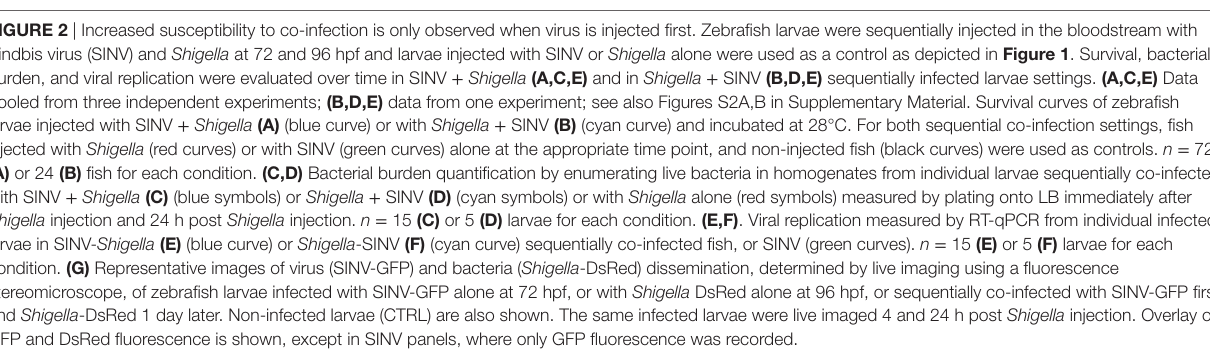
FigUre 2 | Increased susceptibility to co-infection is only observed when virus is injected first. Zebrafish larvae were sequentially injected in the bloodstream with Sindbis virus (SINV) and Shigella at 72 and 96 hpf and larvae injected with SINV or Shigella alone were used as a control as depicted in Figure 1 . Survival, bacterial burden, and viral replication were evaluated over time in SINV + Shigella (a,c,e) and in Shigella + SINV (B,D,e) sequentially infected larvae settings. (a,c,e) Data pooled from three independent experiments; (B,D,e) data from one experiment; see also Figures S2A,B in Supplementary Material. Survival curves of zebrafish larvae injected with SINV + Shigella (a) (blue curve) or with Shigella + SINV (B) (cyan curve) and incubated at 28°C. For both sequential co-infection settings, fish injected with Shigella (red curves) or with SINV (green curves) alone at the appropriate time point, and non-injected fish (black curves) were used as controls. n = 72 (a) or 24 (B) fish for each condition. (c,D) Bacterial burden quantification by enumerating live bacteria in homogenates from individual larvae sequentially co-infected with SINV + Shigella (c) (blue symbols) or Shigella + SINV (D) (cyan symbols) or with Shigella alone (red symbols) measured by plating onto LB immediately after Shigella injection and 24 h post Shigella injection. n = 15 (c) or 5 (D) larvae for each condition. (e,F) . Viral replication measured by RT-qPCR from individual infected larvae in SINV- Shigella (e) (blue curve) or Shigella -SINV (F) (cyan curve) sequentially co-infected fish, or SINV (green curves). n = 15 (e) or 5 (F) larvae for each condition. (g) Representative images of virus (SINV-GFP) and bacteria ( Shigella -DsRed) dissemination, determined by live imaging using a fluorescence stereomicroscope, of zebrafish larvae infected with SINV-GFP alone at 72 hpf, or with Shigella DsRed alone at 96 hpf, or sequentially co-infected with SINV-GFP first and Shigella -DsRed 1 day later. Non-infected larvae (CTRL) are also shown. The same infected larvae were live imaged 4 and 24 h post Shigella injection. Overlay of GFP and DsRed fluorescence is shown, except in SINV panels, where only GFP fluorescence was